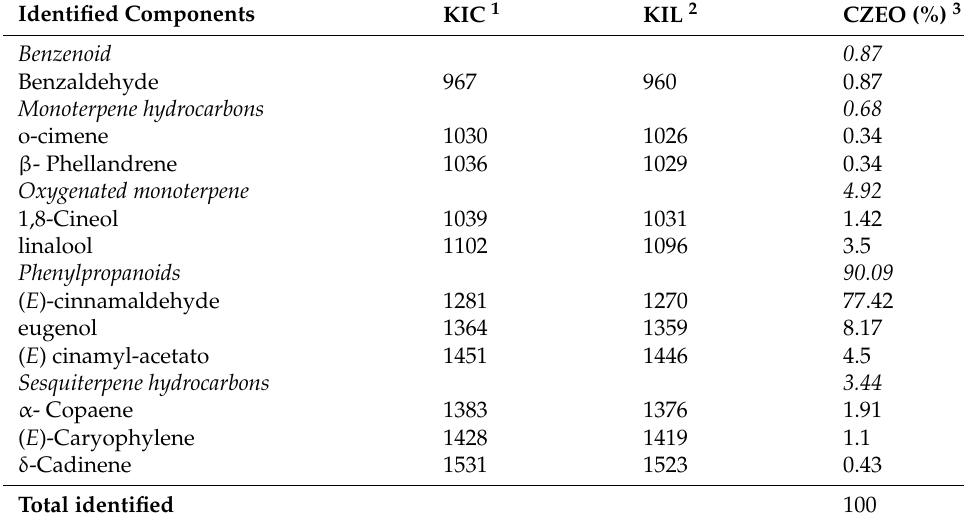
Table A1. Percentage of the Cinnamomum zeylanicum Essential Oil Chemical